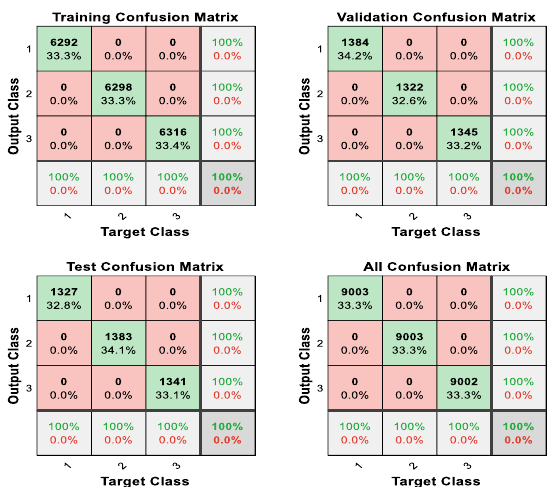
Fig. 9 Confusion matrix of the developed machine model